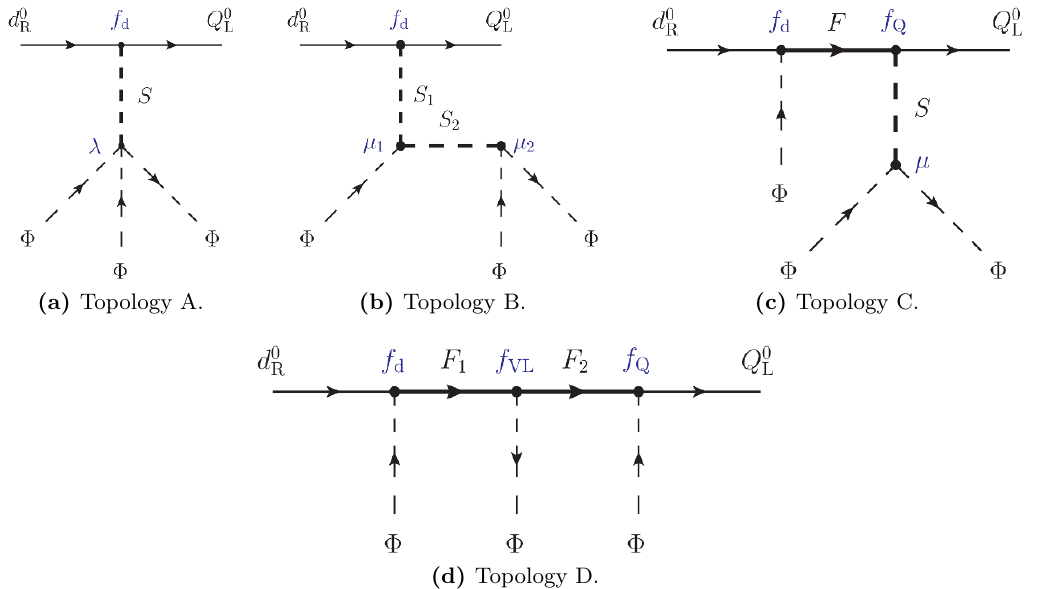
Figure 2 . Tree-level topologies of the Yukawa operator for down-type quarks, see table 2. Similar diagrams exist for up-type